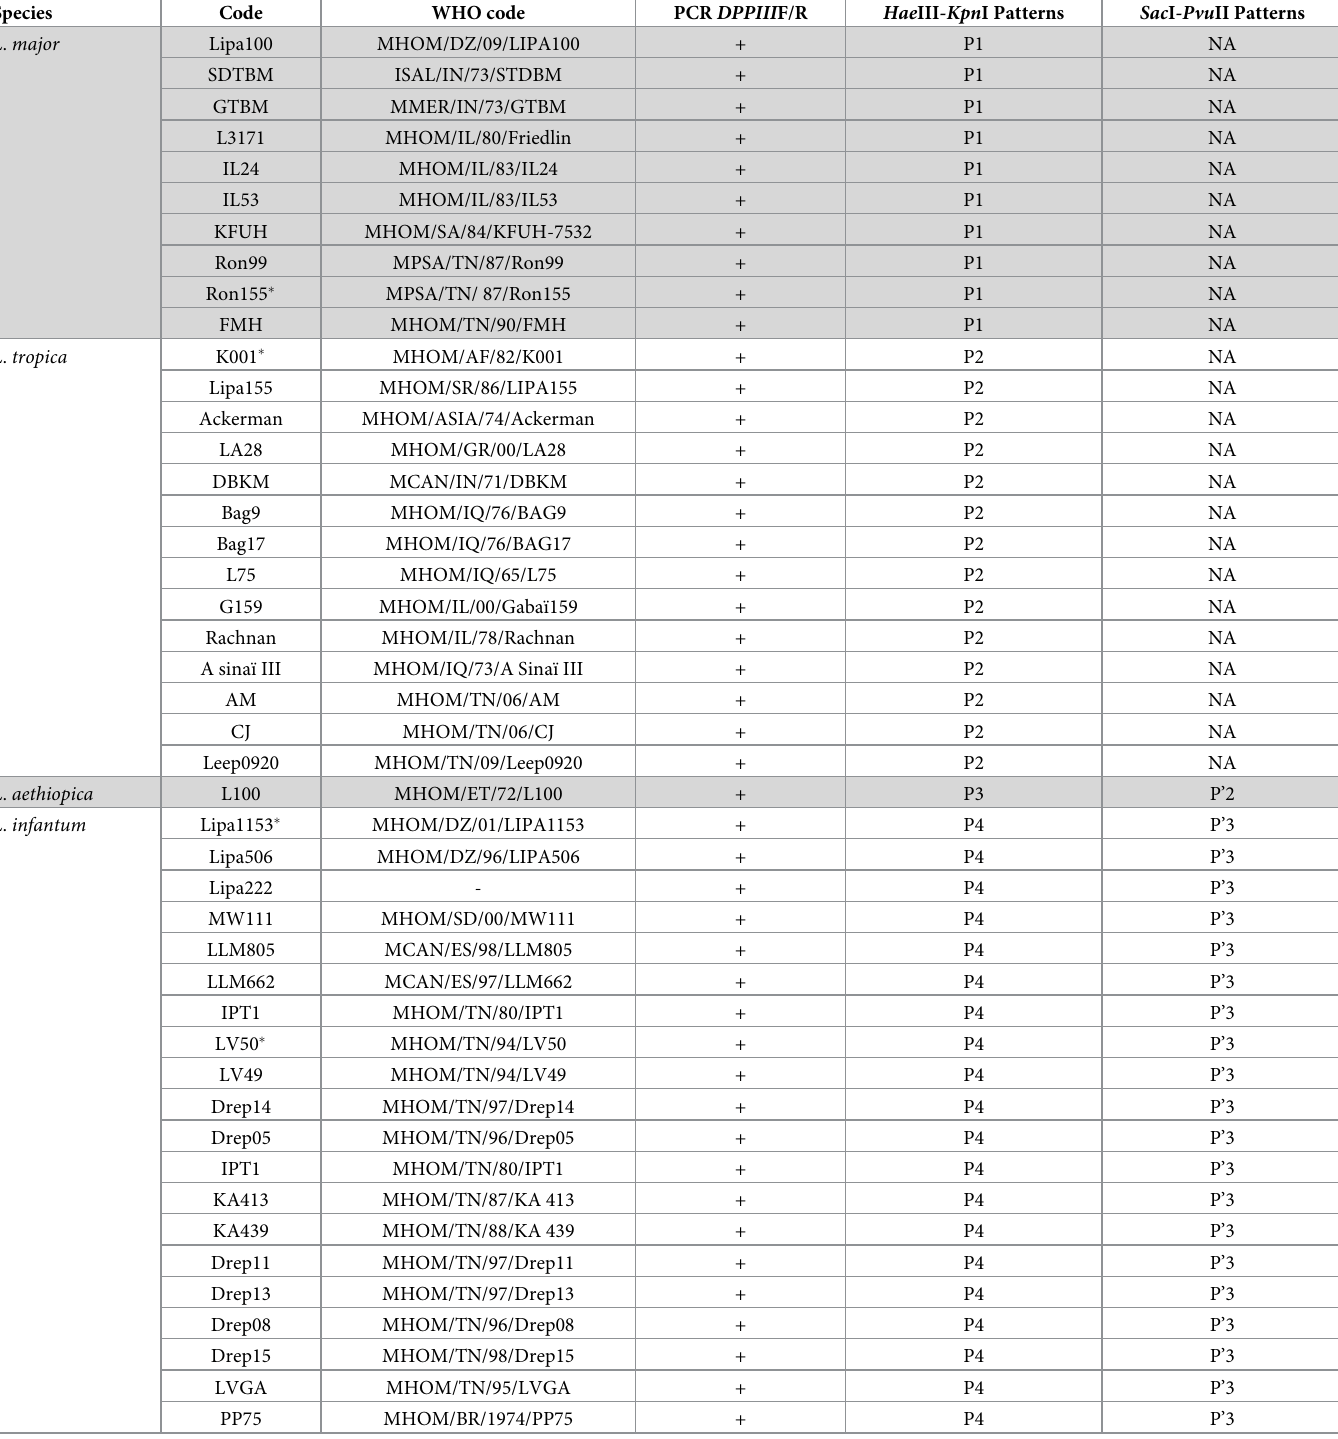
Table 2. PCR-RFLP patterns of the studied strains.